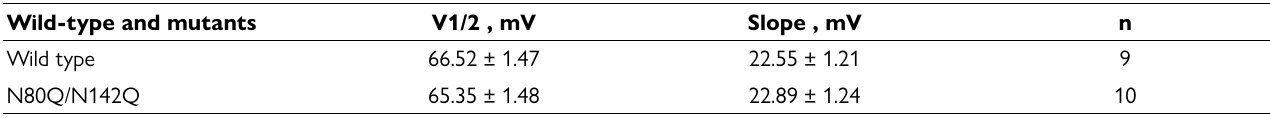
and slope of conductance vs. voltage curves. Table 1. Effect of deglycosylation on V 1/2 Wild-type and mutants V1/2 , mV Slope , mV n Wild type 66.52 ± 1.47 22.55 ± 1.21 9 N80Q/N142Q 65.35 ± 1.48 22.89 ± 1.24